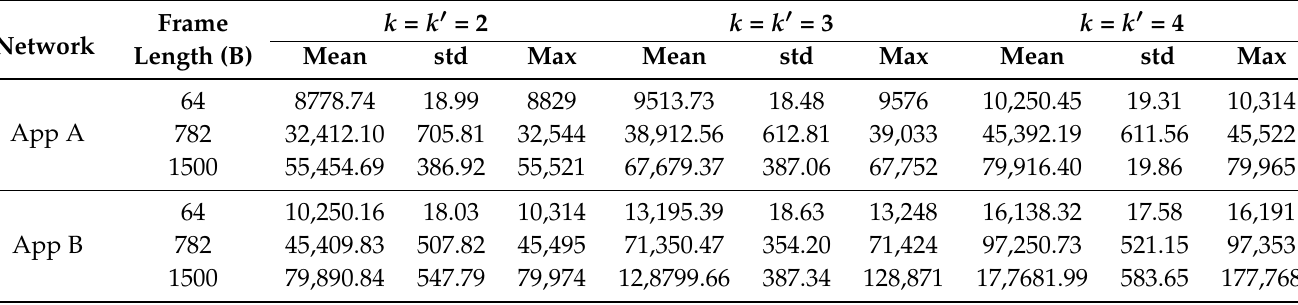
Table 3. Maximum end-to-end delay in nanoseconds when transmitting two, three and four replicas using approach A and approach